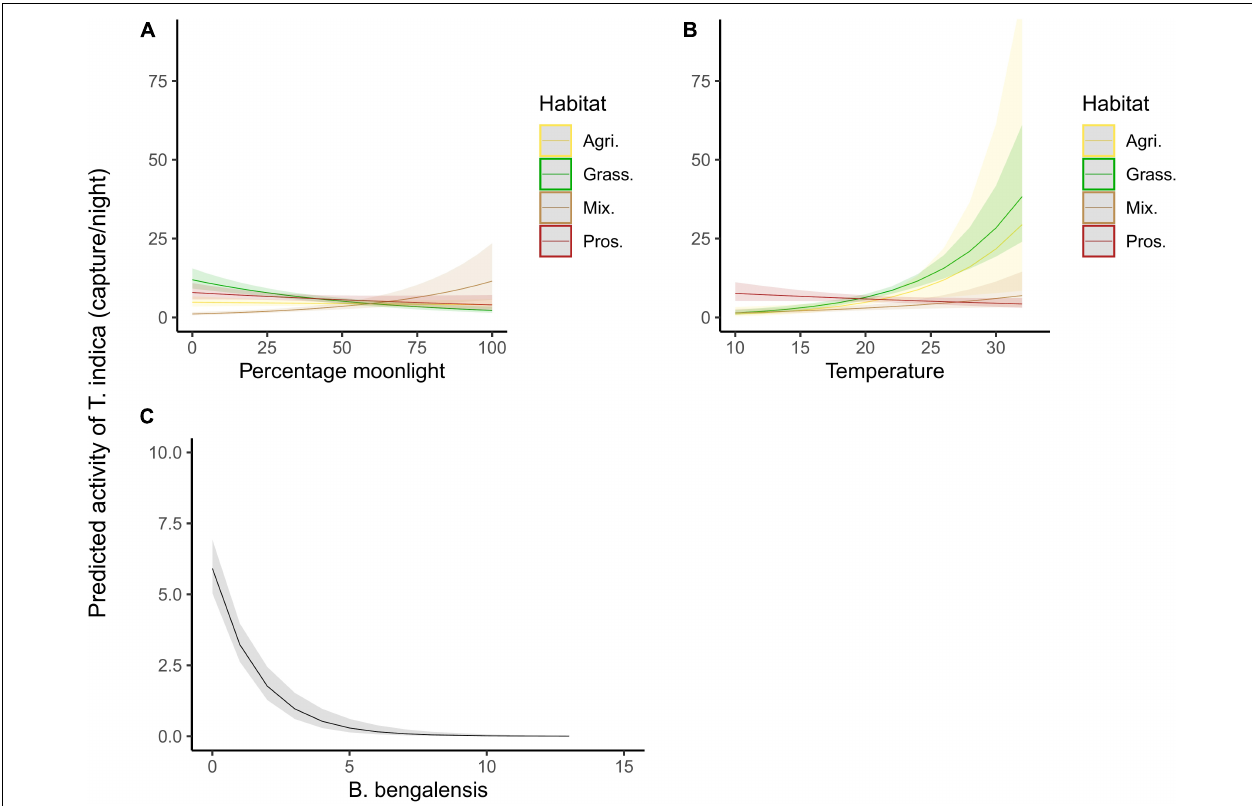
FIGURE 3 | Predicted response of the activity of T. indica to different predictor variables based on top model. (A) Effect of percentage moon luminosity on activity under different habitat cover. (B) Effect of minimum nighttime temperature on activity under different habitat cover. (C) Effect of co-occurring B. bengalensis on the activity of T. indica